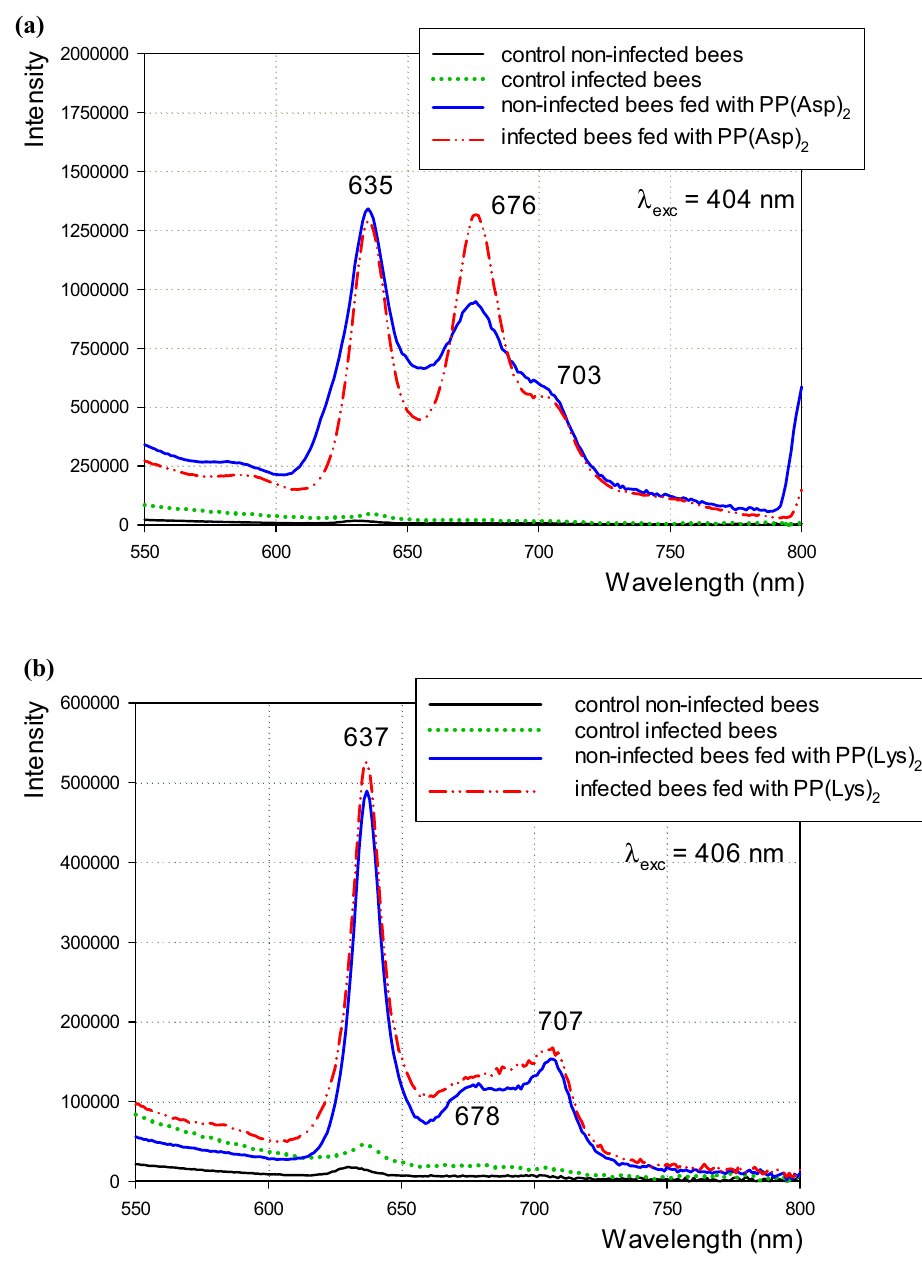
Figure 5. Fluorescence spectra of the honeybee hemolymph showing the presence of protoporphyrin IX amide derivatives ( a ) PP(Asp) 2 and ( b ) PP(Lys) 2 inside the